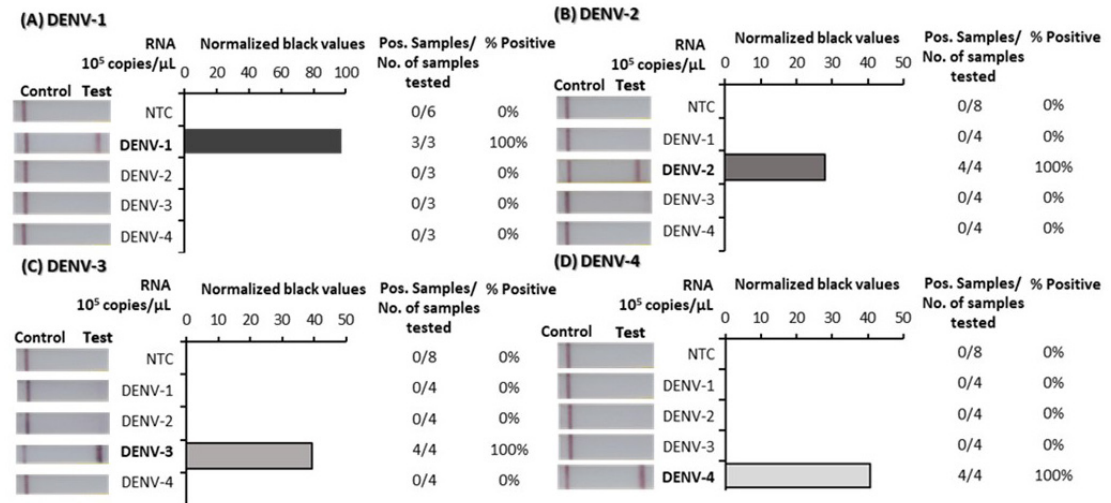
Figure 3. Analytical specificity trials of dengue virus (DENV) 1–4 reverse-transcription recombinase polymerase amplification lateral flow detection (RT-RPA/LFD) tests using in vitro transcribed RNA. Non-structural 5 (NS5) gene fragment RNA transcripts specific to each DENV serotype were tested for detection by each specific RT-RPA/LFD test: DENV-1 ( A ), DENV-2 ( B ), DENV-3 ( C ) and DENV-4 ( D ). Images of lateral flow strips (LFS) with two bands (control and test band) indicates the sample is positive for respective DENV RNA, and single control band indicates a valid reaction with negative sample (left). Normalised pixel density (black values) from the lateral flow test strip test bands of each DENV template RNA (10 5 copies/μL) and no template control (NTC) displayed (middle). Positive (Pos.) samples compared to number (No.) of samples tested were used to calculate percentage of positive samples